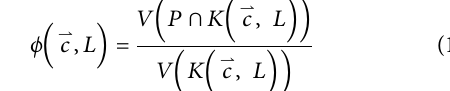
Frontiers in Physics |